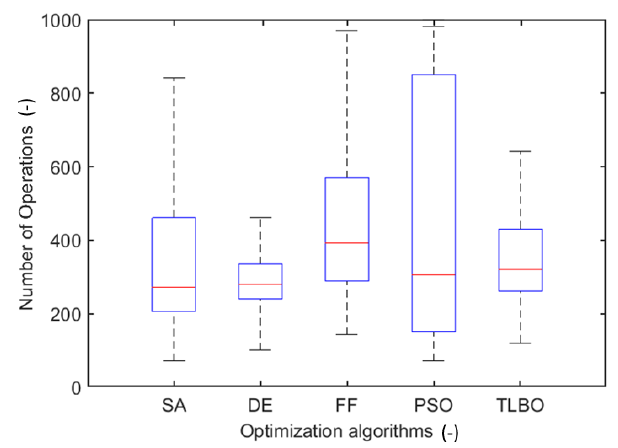
Figure 9. Box plot with the number of operations needed to reach the solution: depicted in box plot with median, 25th percentile and 75th percentile.